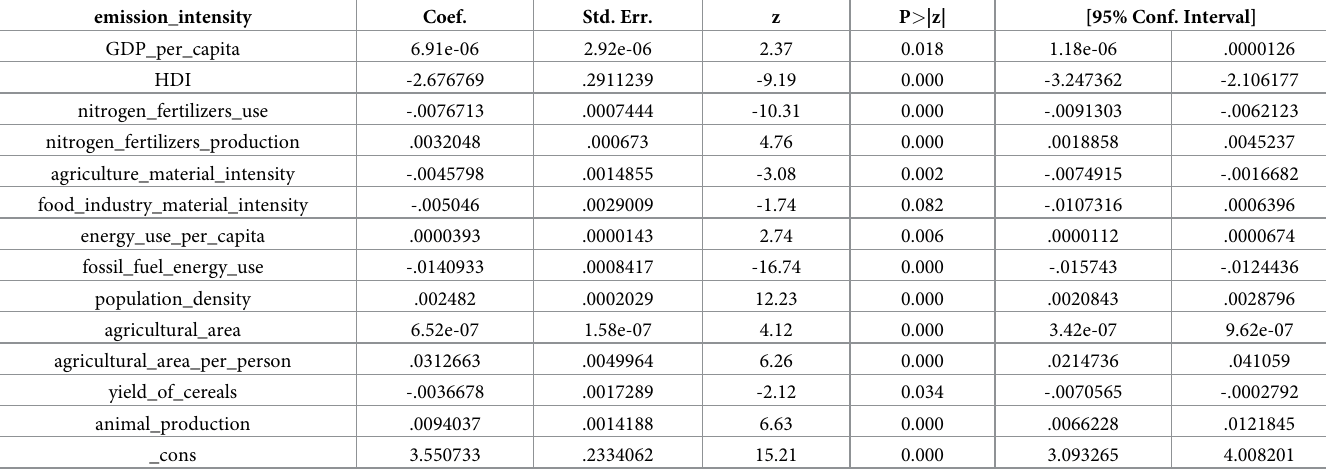
Table 2. Emission intensity of food production systems. Linear regression, correlated panels corrected standard errors (PCSEs).